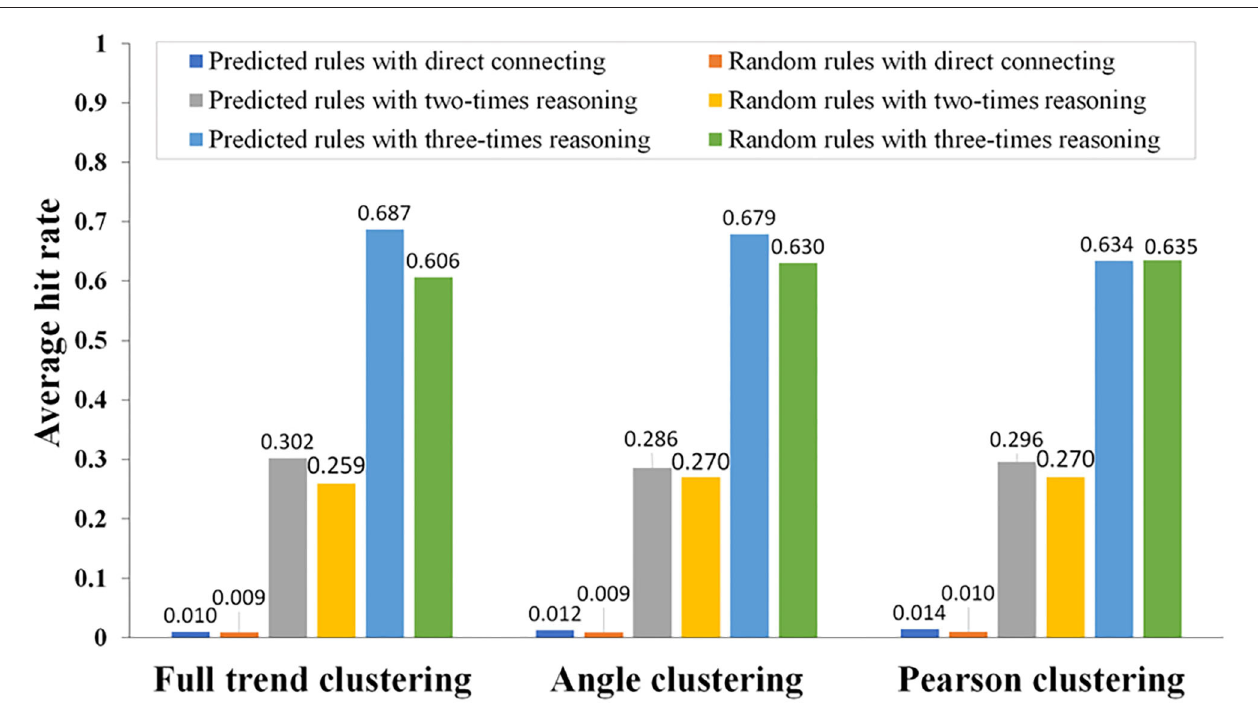
FIGURE 5 | Comparison of the association rules predicted by DCAA and the random association rules using different reasoning modes. Using different clustering methods (direct connection, twofold reasoning, and threefold reasoning), the hit rates of association rules were calculated by comparing the predicted association rules with the association rules recorded in the DIP. Hit rates of DCAA and random matching were compared to judge whether there was a significant difference.